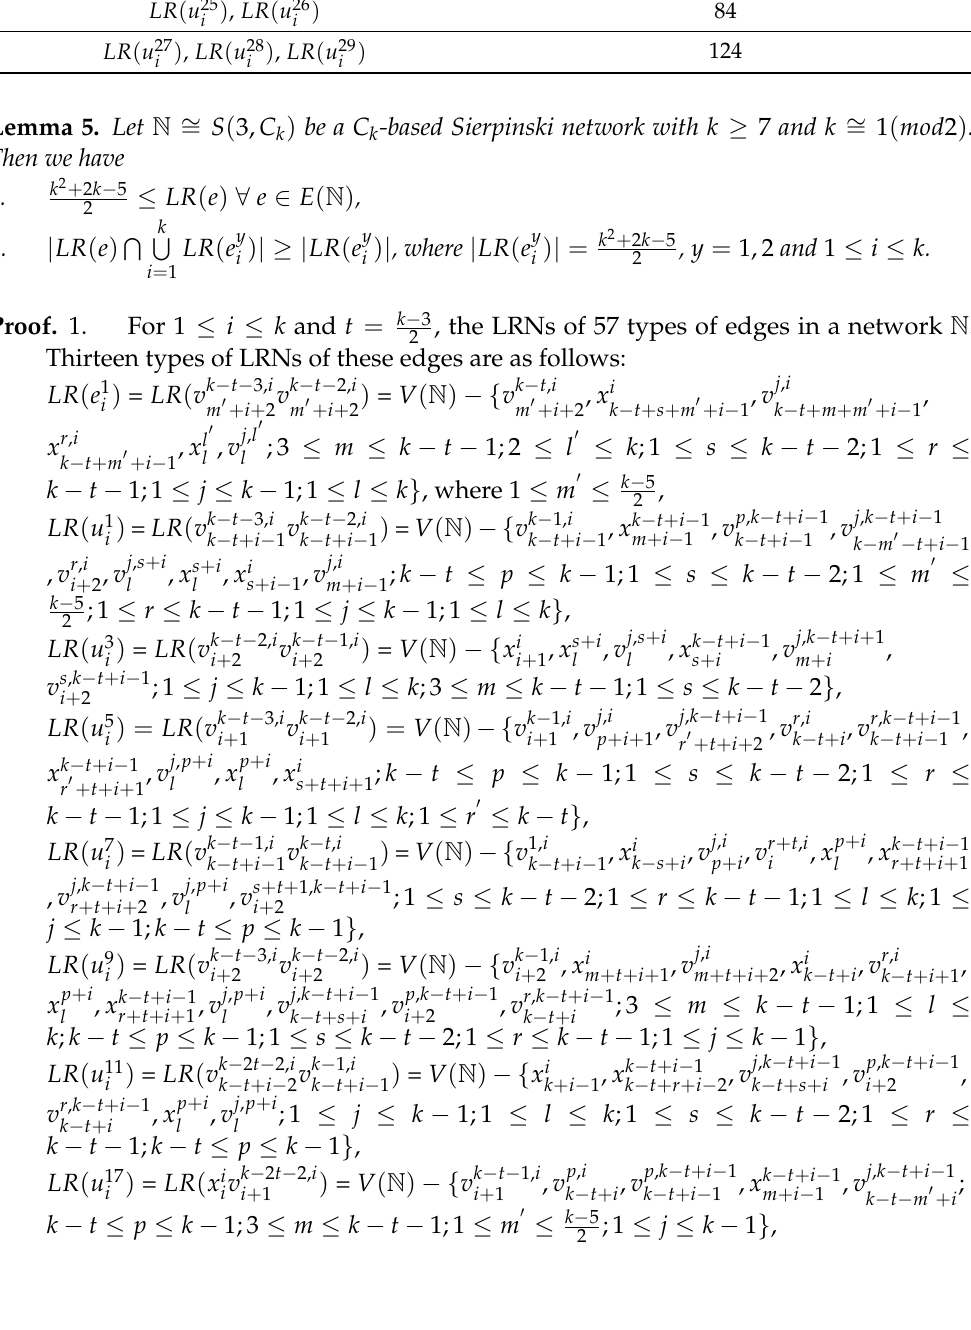
Table 3. Local resolving neighborhood set (LRNs) LR ( e y